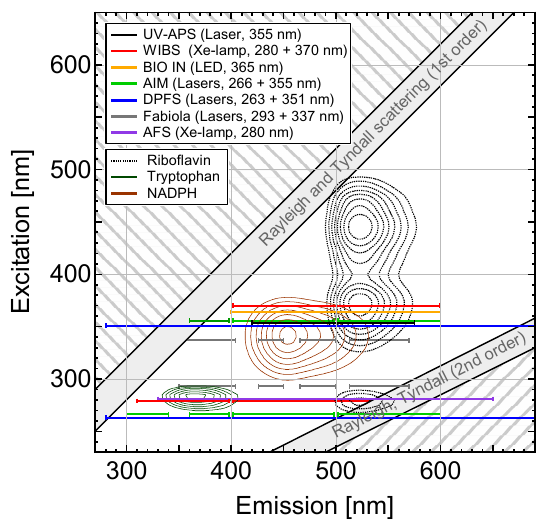
Fig. 1. Conceptual EEM displaying: (a) fluorescence data area (white), areas strongly influenced by Rayleigh and Tyndall light scattering (grey diagonal bars), areas without meaningful data (grey stripes); (b) contour lines for the fluorophores tryptophan, NADPH and riboflavin; (c) operational range of selected bioaerosol detec- tors represented by horizontal colored lines. Length of individ- ual lines indicates measured emission band for a certain excita- tion wavelength shown as sharp line for purpose of clarity. Single- wavelength detectors are represented by one line,